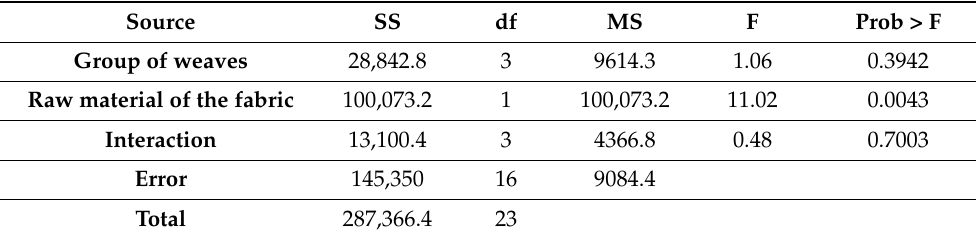
Table 5. ANOVA results for fabric air